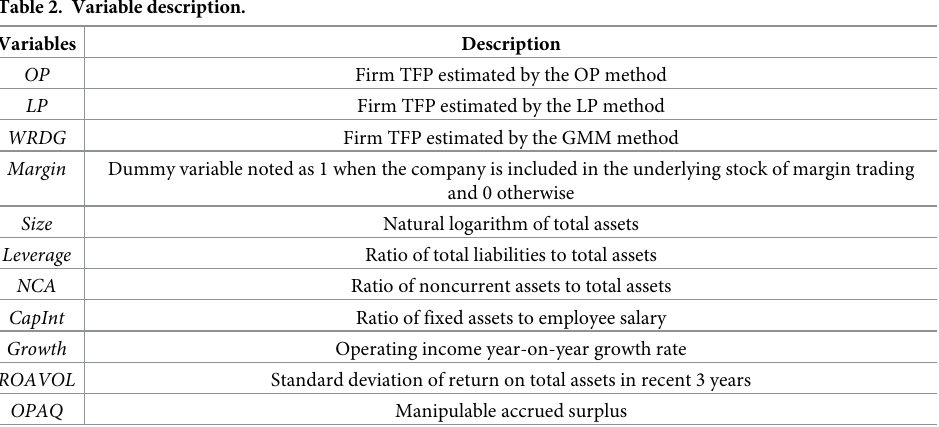
Table 2. Variable